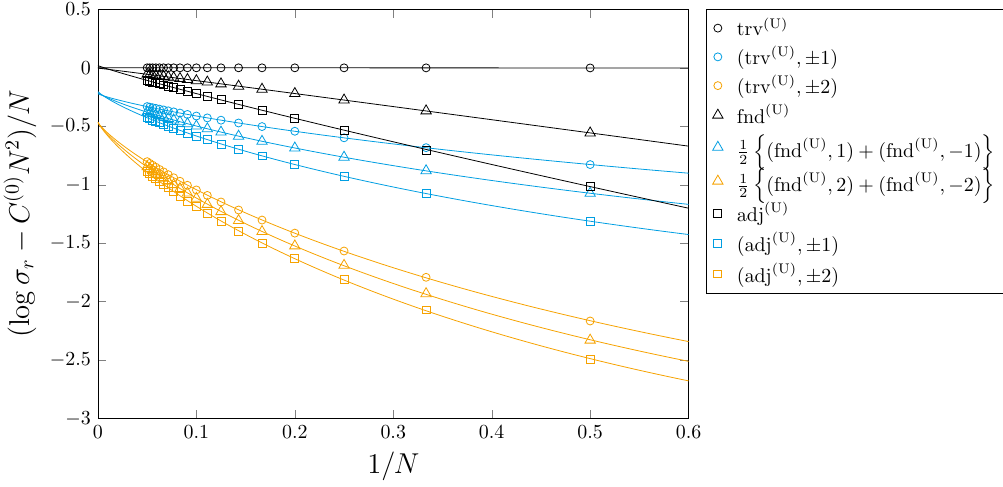
Figure 11 . The quantity (log σ r − C (0) N 2 ) /N is plotted against 1 /N for the trivial, fundamental and adjoint representations in the U ( N ) gauge theory with λ = 3 . We also plot the same quantity for representations with nonzero charge with different colors. The lines represent fits of the results for each representation with N ≥ 2 to a + bχ N /N + c/N . For the sequences of representations without charge, the fits yield a = b = 0 within fitting